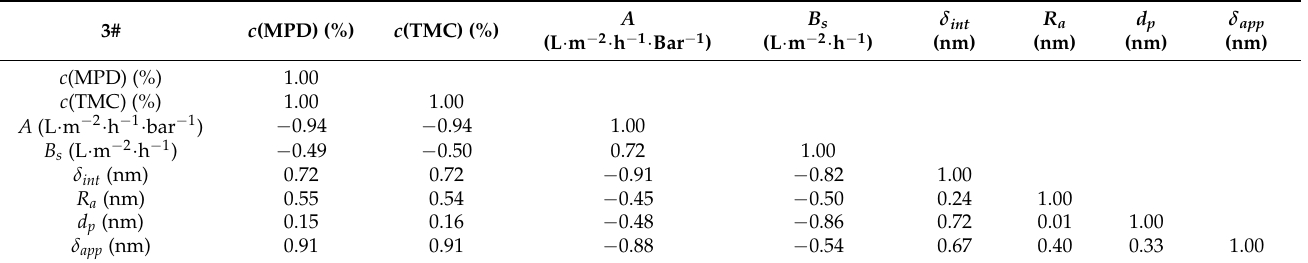
Figure 12. Series 3. ( a ) the variation in A value and the δ int ; ( b ) the analysis of the B s and R boron . Table 5. The analysis of correlation coefficients in series